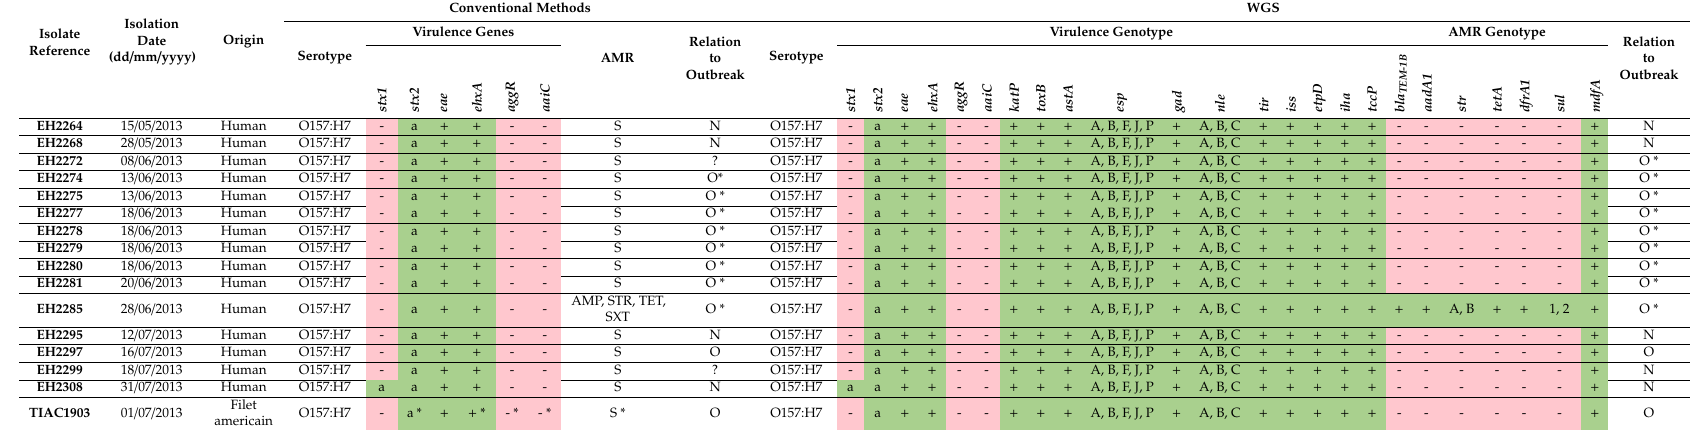
Table 2. The characteristics of and relatedness between the isolates with similar characteristics collected during the Flanders 2013 outbreak period, determined with conventional methods and WGS data